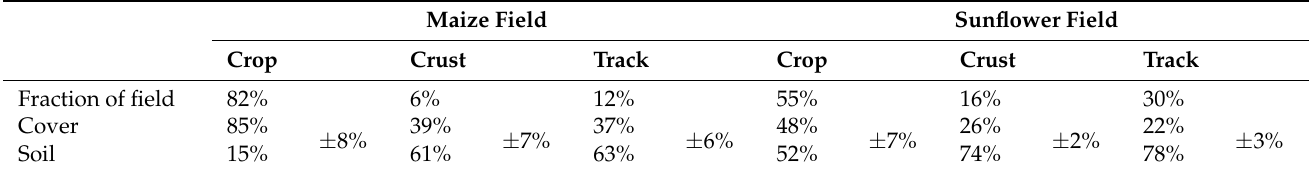
Table 5. The percentage of the planting row, track, and crusts in size, and the identified surface area of each row type.